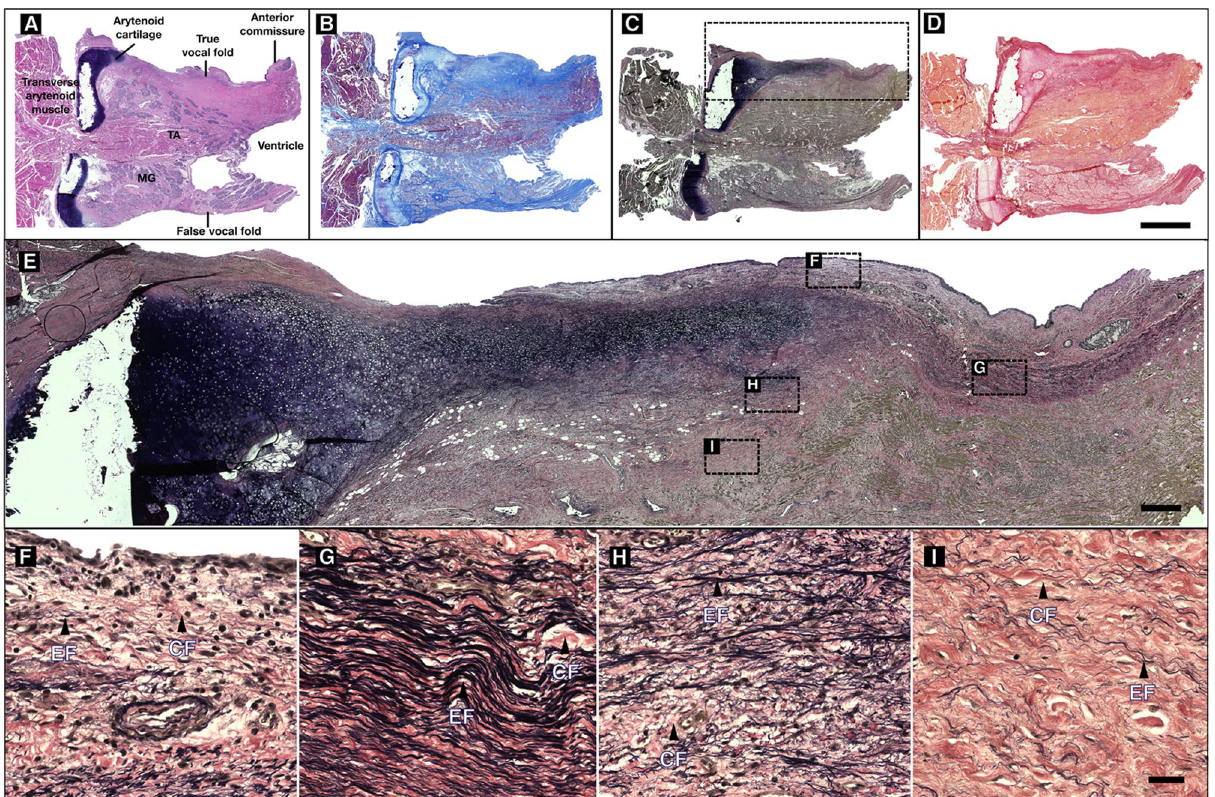
Figure 4. Sagittal sections of the human adult vocal fold. Medial (A) to lateral (D) sagittal sections of a 50-year-old female vocal fold under low magnification (10x). Each slide from the anterior commissure to the vocal process shows a different contrast. The true vocal fold thickens posteriorly and laterally. Verhoeff stain (C) highlight the elastic fibers band (stained in black) that extend along the full length of the vocal fold with inset showing a magnification at × 20 (E). The distribution of elastin varies according to the depth and anteroposterior position on the true vocal fold (E) , as shown through a × 60 magnification on insets (F–I) with arrows pointing to elastic (EF) and collagen fibers (CF). (A) Hematoxylin and eosin, (B) Masson trichome, (C,F–I) Verhoeff. (D) Picrosirius red – Scale bars: 5 mm [ A – D ], 500 μm [ E ], 50 μm [ F – I